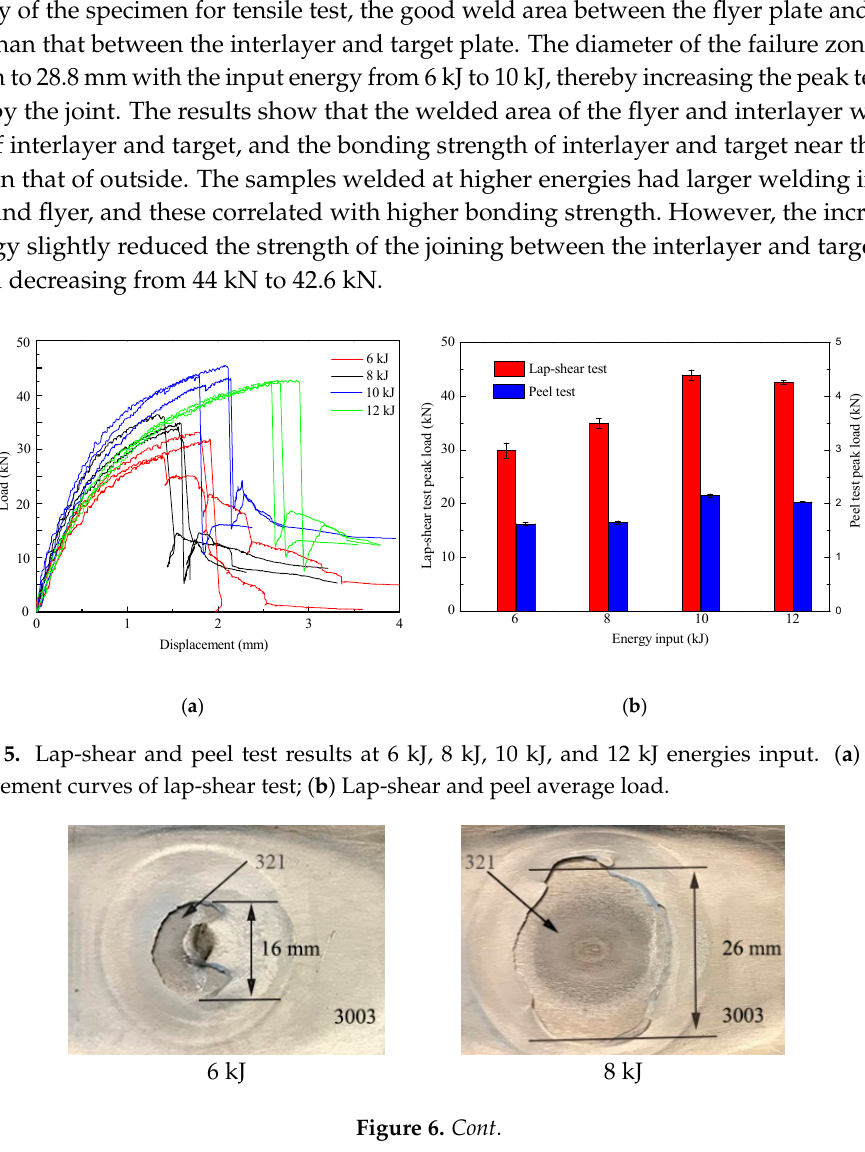
Table 2. Lap-shear and peel test results.